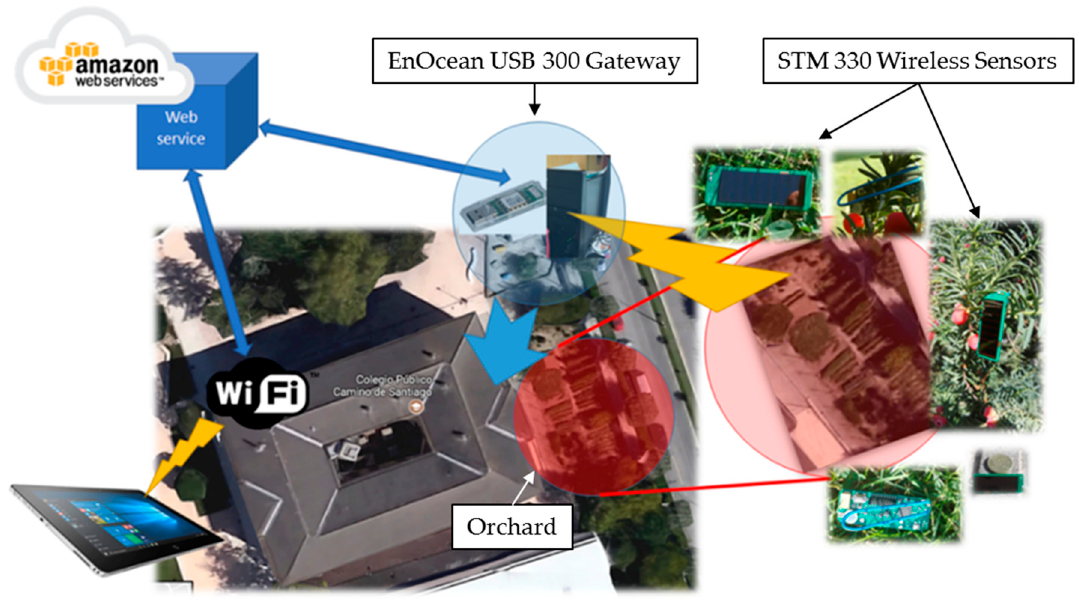
Figure 11. Scheme of the system architecture.